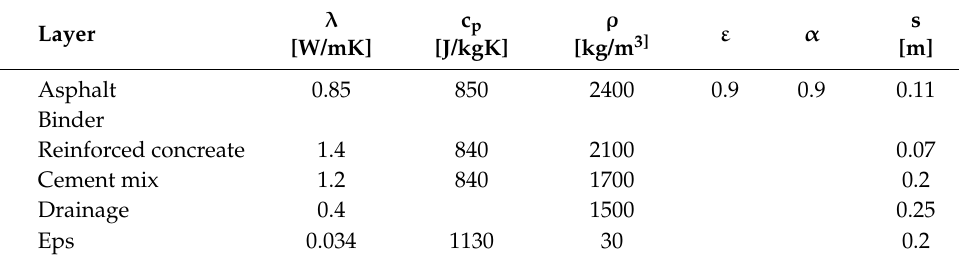
Table 4. Thermophysical characteristics of the RTC